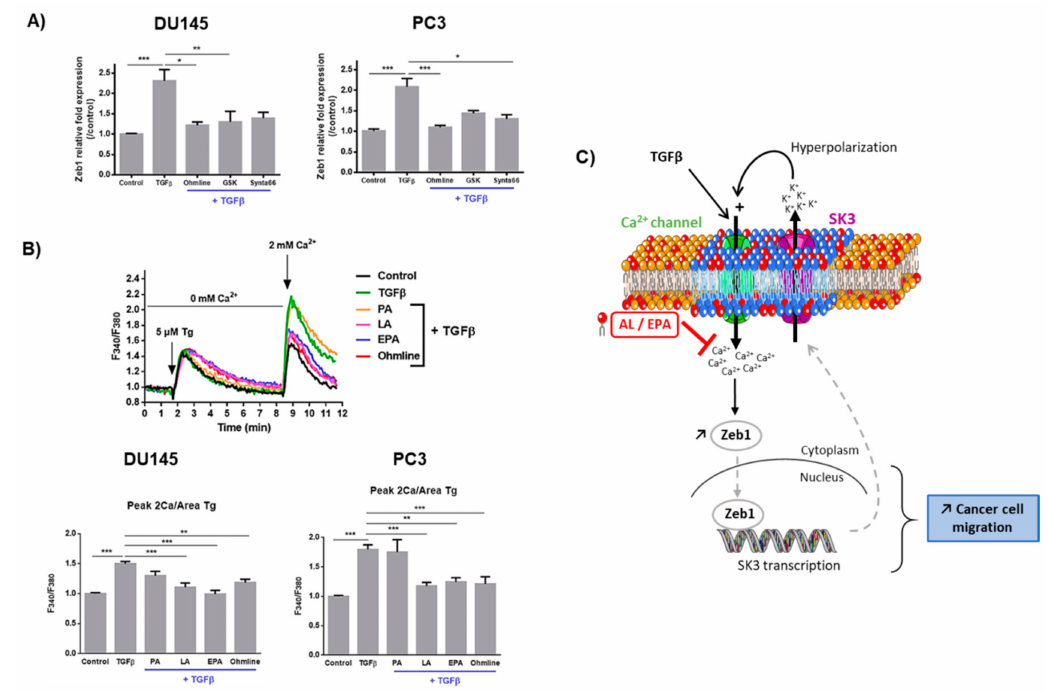
Figure 4. Ca 2 + entry is required for TGF β -induced Zeb1 expression, and TGF β -induced SOCE is inhibited by LA and EPA. ( A ) Zeb1 expression is inhibited by an SK3 channel inhibitor and Ca 2 + channel inhibitors. PCa cells were treated with TGF β (10 ng / mL) ± GSK7975A (GSK in the figure), Synta66,